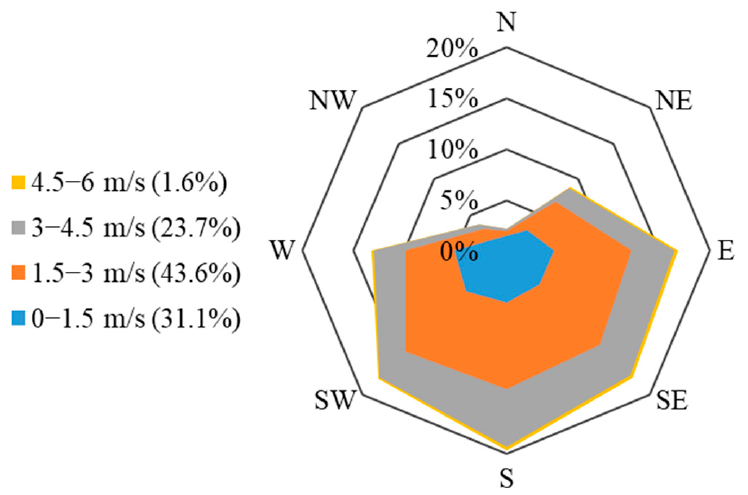
Figure 3. Wind rose showing frequency distributions of associated wind direction and wind speed based on favourable outdoor temperature conditions during Beijing’s study period.